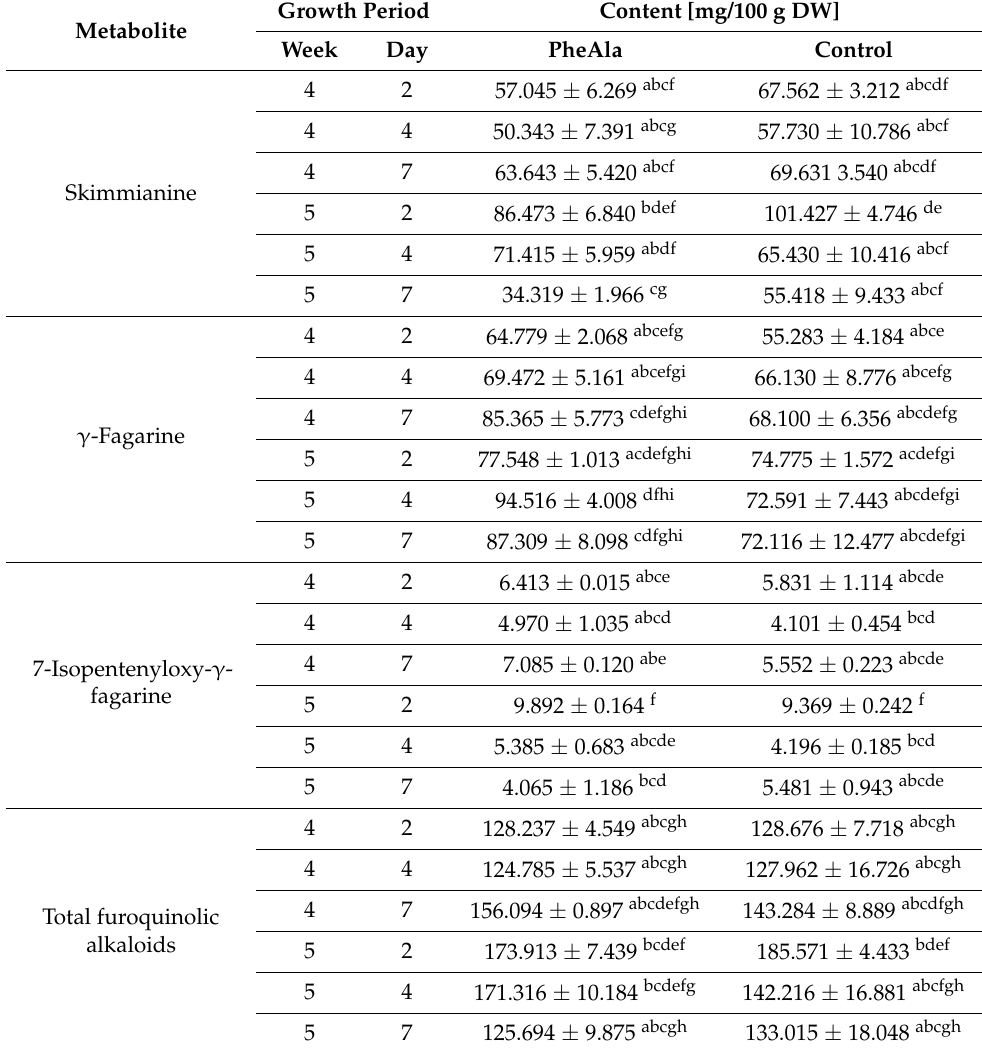
Table 4. Average content of furoquinoline alkaloids [mg/100 g DW] in methanol extracts obtained from the biomass of R. graveolens agitated cultures, depending on the duration of the growth cycle (4 and 5 weeks) and day after addition of phenylalanine (2, 3, and 7 days). Means of three measure- ments ± SD. Different letters indicate significant differences ( p < 0.05).